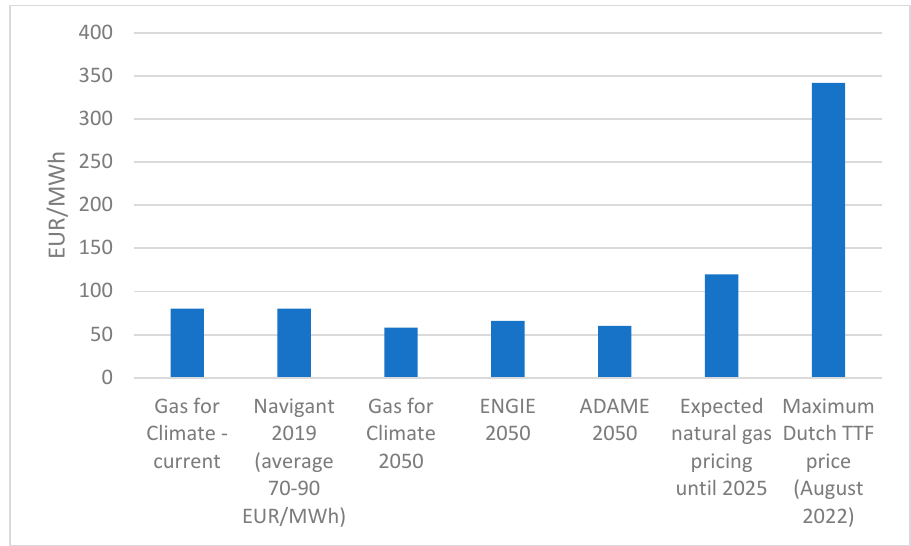
Figure 13. Production costs of biomethane (EUR/MWh). Source: own elaboration based on [56,112].